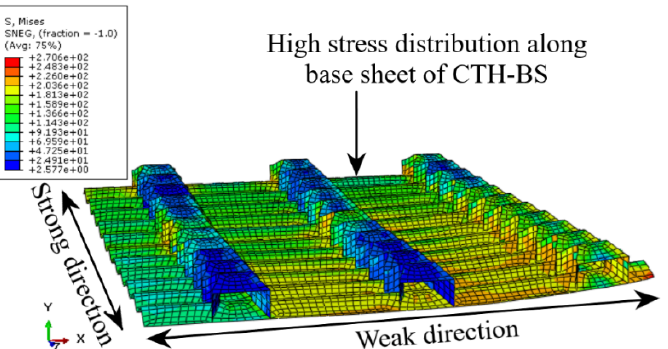
Figure 13. Failed CTH-BS deck with high stress along base sheet indicating higher load distribution along the weak direction.